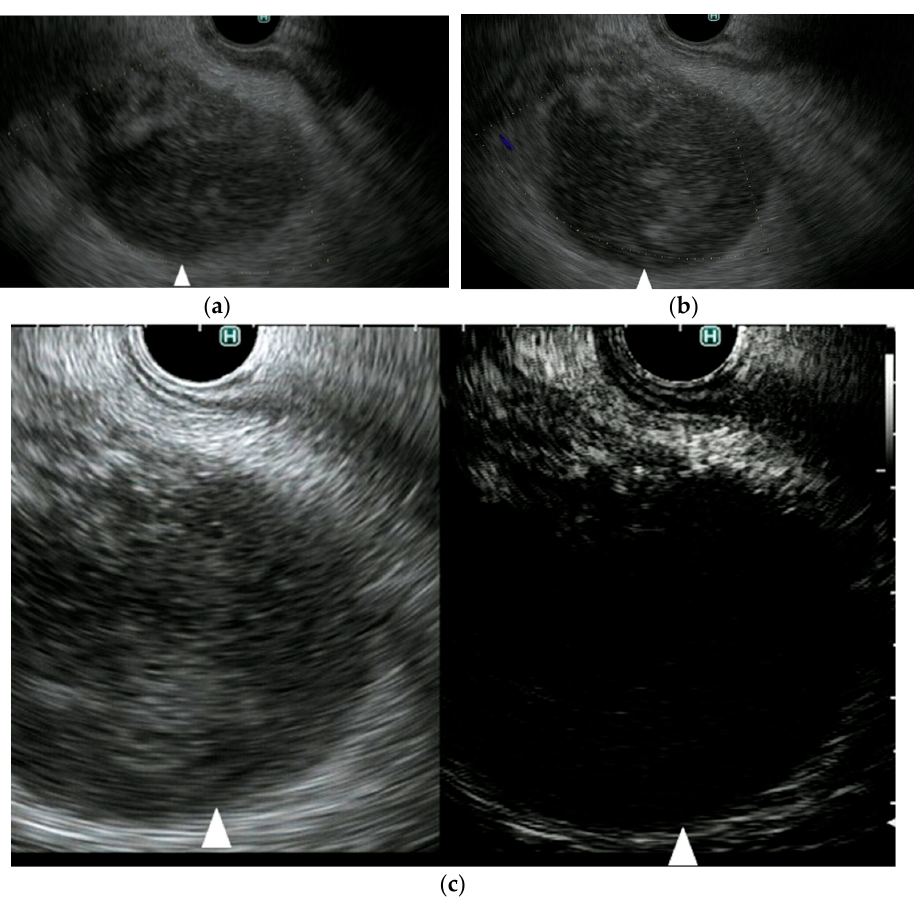
Figure 7. A representative case of gallbladder sludge. ( a ) DFI endoscopic ultrasonography shows no vascularity in the gallbladder lesion (arrow). ( b ) e-FLOW endoscopic ultrasonography shows no vascularity in the gallbladder lesion (arrow). ( c ) Contrast-enhanced endoscopic ultrasonography shows no vascularity in the gallbladder lesion (arrow).